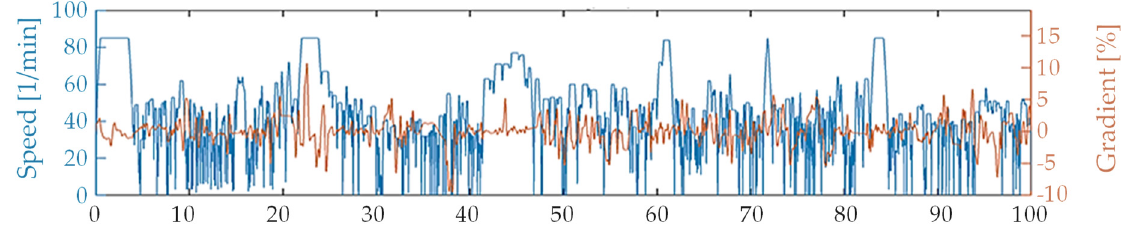
Figure 2. Urban delivery cycle of VECTO according to [1].